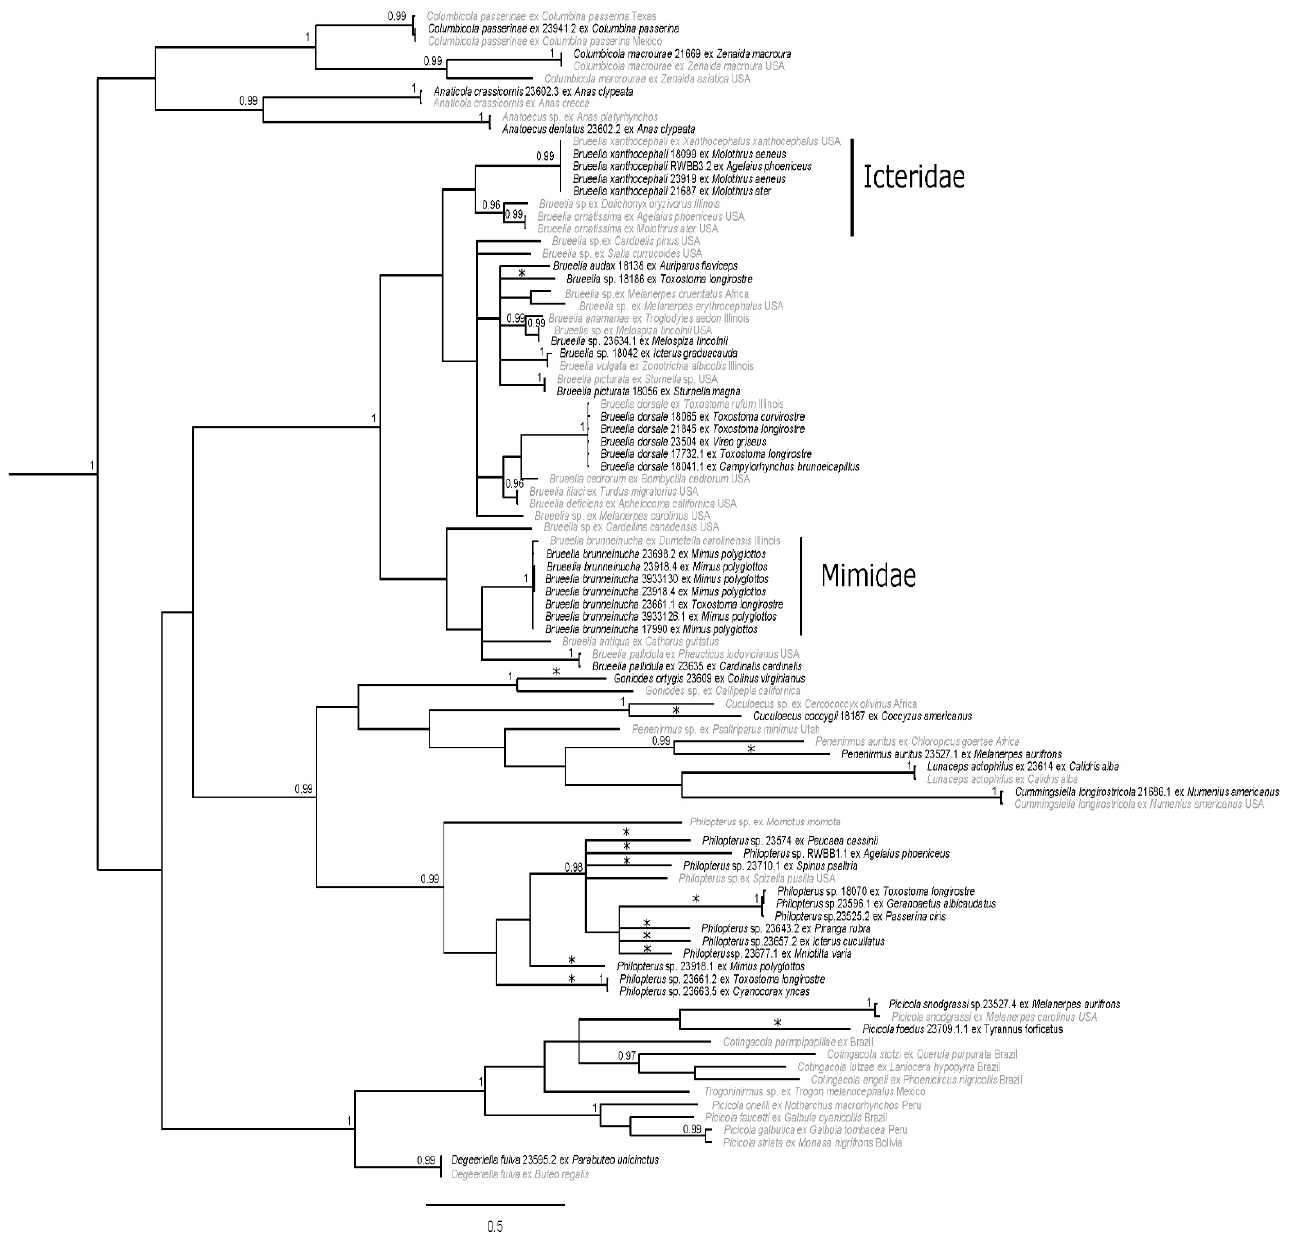
Figure 3. Bayesian phylogram of ischnoceran taxa from south Texas. Posterior probabilities ≥ 0.95 are shown and sequences in gray are from GenBank. Distinct genetic lineages are denoted with asterisks (*); two of these lineages ( Goniodes ortygis , Penenirmus auritus ) represent morphologically described taxa. The host families Icteridae and Mimidae are shown to the right of louse clades exclusively shown here to parasitize them. Taxon labels for newly sequenced specimens include the louse species (if identified), unique identifier (generally matching the host voucher number), and host species. Taxon labels for GenBank specimens include louse species (if known), host species, and sampling location (if known). Outgroup taxa have been pruned.